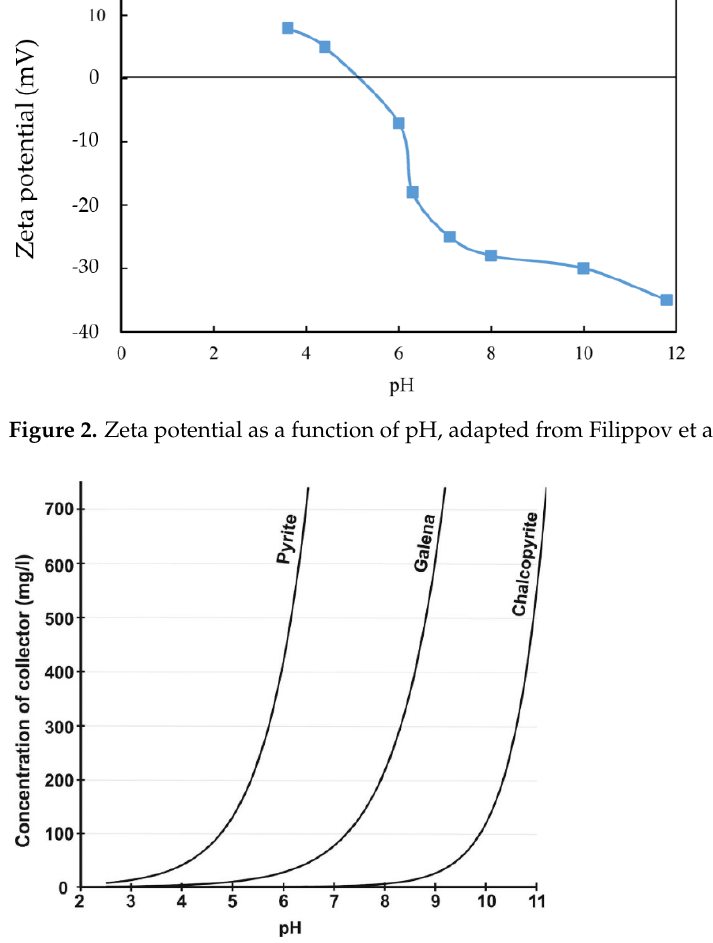
Figure 3. The effect of collector concentration and pH value in the flotation of chalcopyrite, pyrite and galena, adapted from Wark and Cox [43].